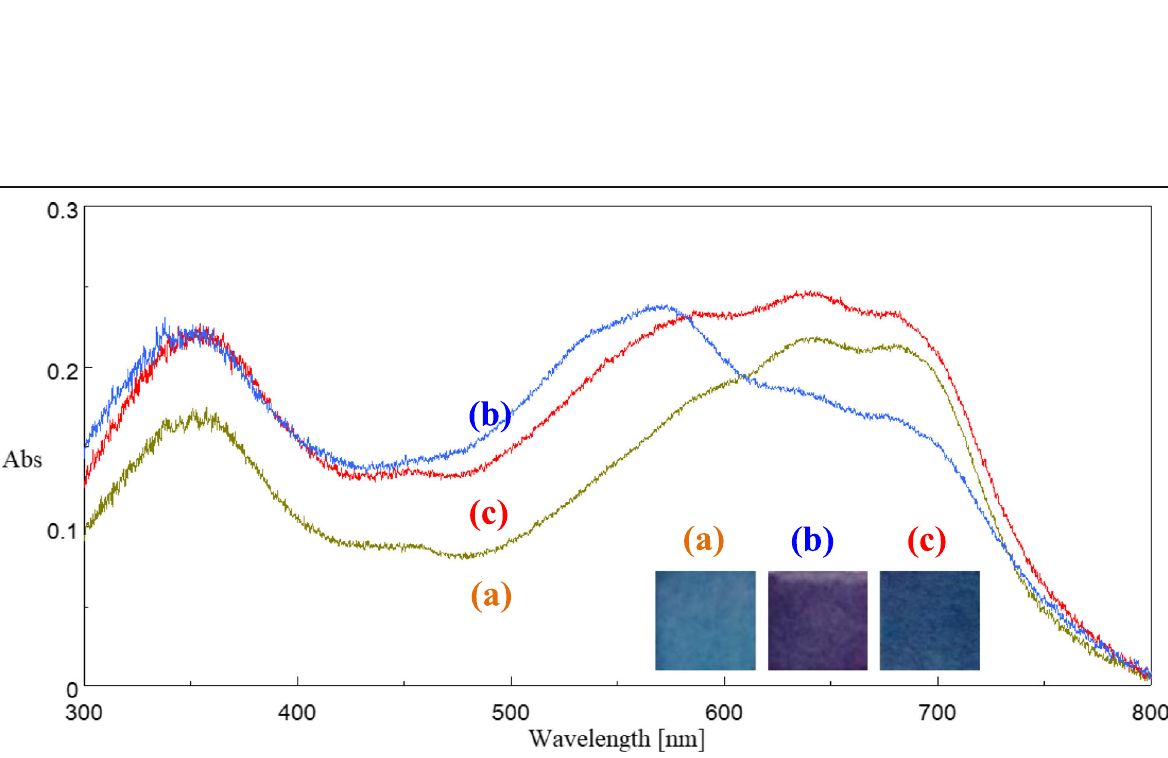
Fig. 3 UV-vis spectra and images of EBT-CC before (a) and after equilibration in Mg(II) solution (b) or Ca(II) solution